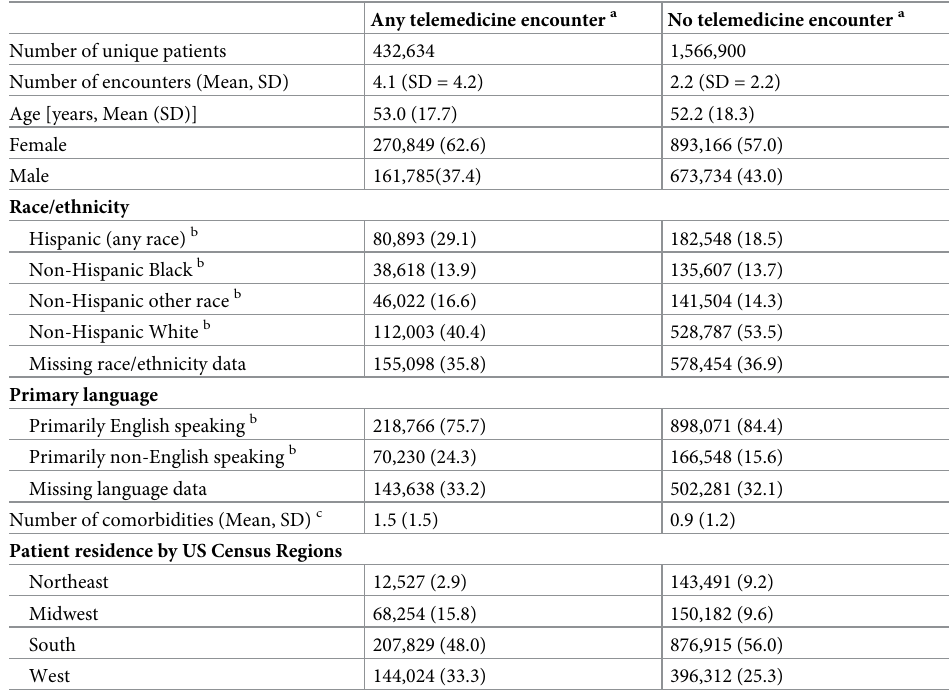
Table 1. Patient characteristics by telemedicine utilization. Any telemedicine encounter a No telemedicine encounter